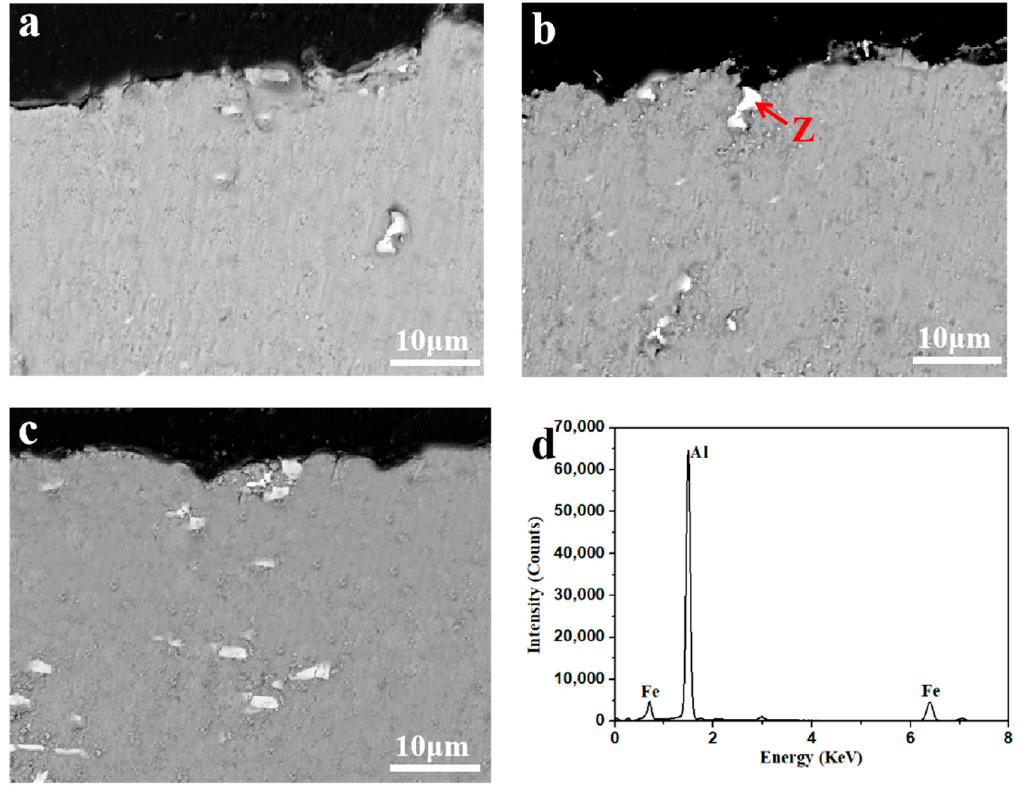
Figure 6. Corrosion cross sectional SEM/BSE images of the Al-xFe-0.07La alloy foils in 3.5% NaCl solution: ( a ) Al-0.07Fe-0.07La; ( b ) Al-0.1Fe-0.07La; ( c ) Al-0.2Fe-0.07La; ( d ) EDS analysis of phase Z.